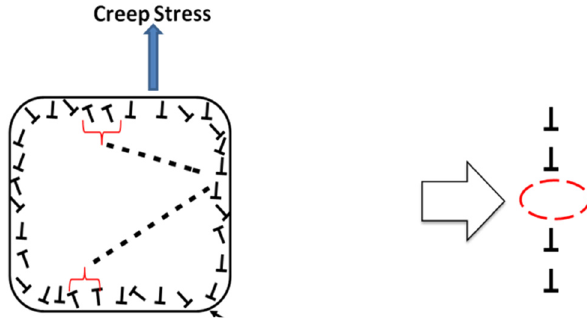
Figure 2: Schematic diagram showing knit - in of mobile dislocations with the boundary dislocations ( dotted lines indicate dislocation path [ assumed ] under creep stress )